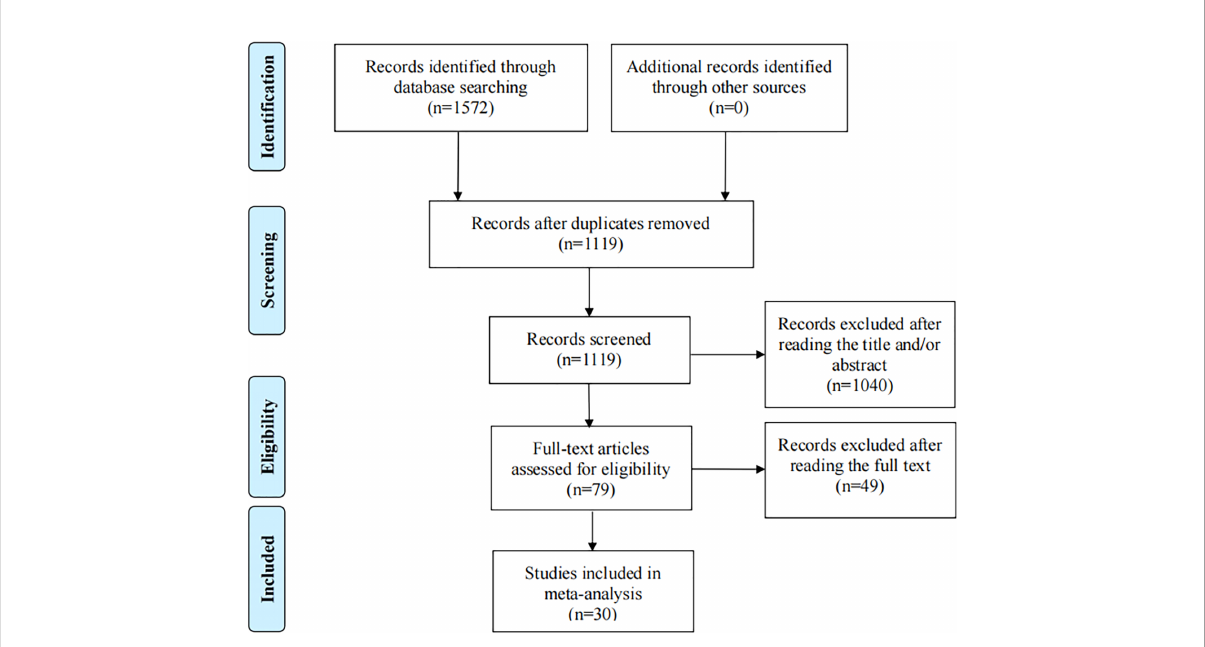
FIGURE 1 Flow diagram of the process of selection of